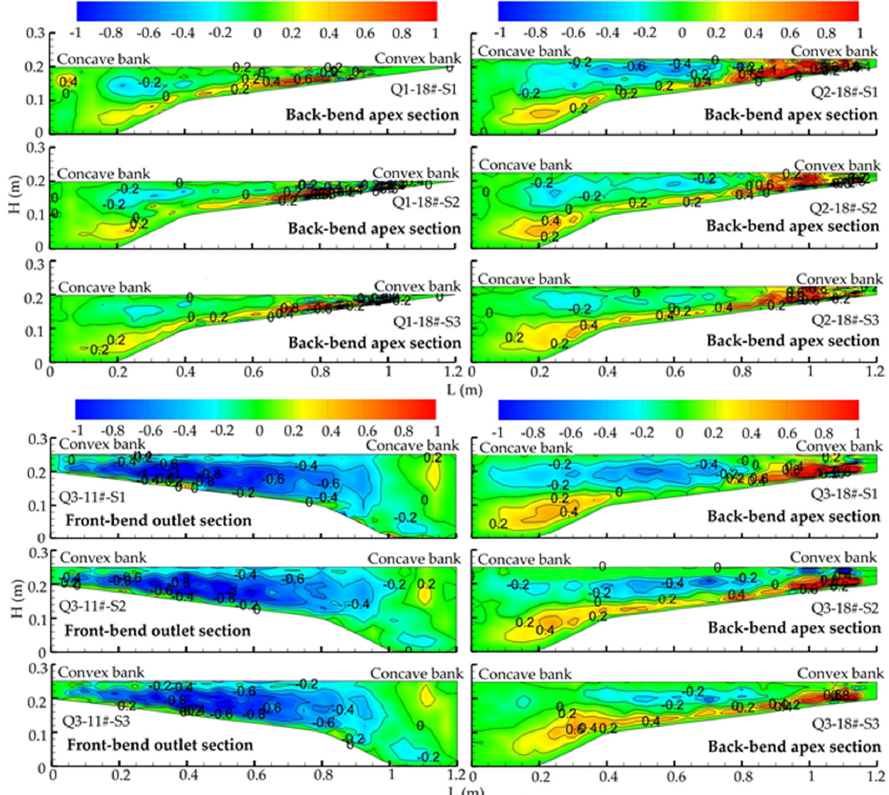
Figure 8. Distribution of the circulation intensity of a typical cross-section under different discharges and scenarios.